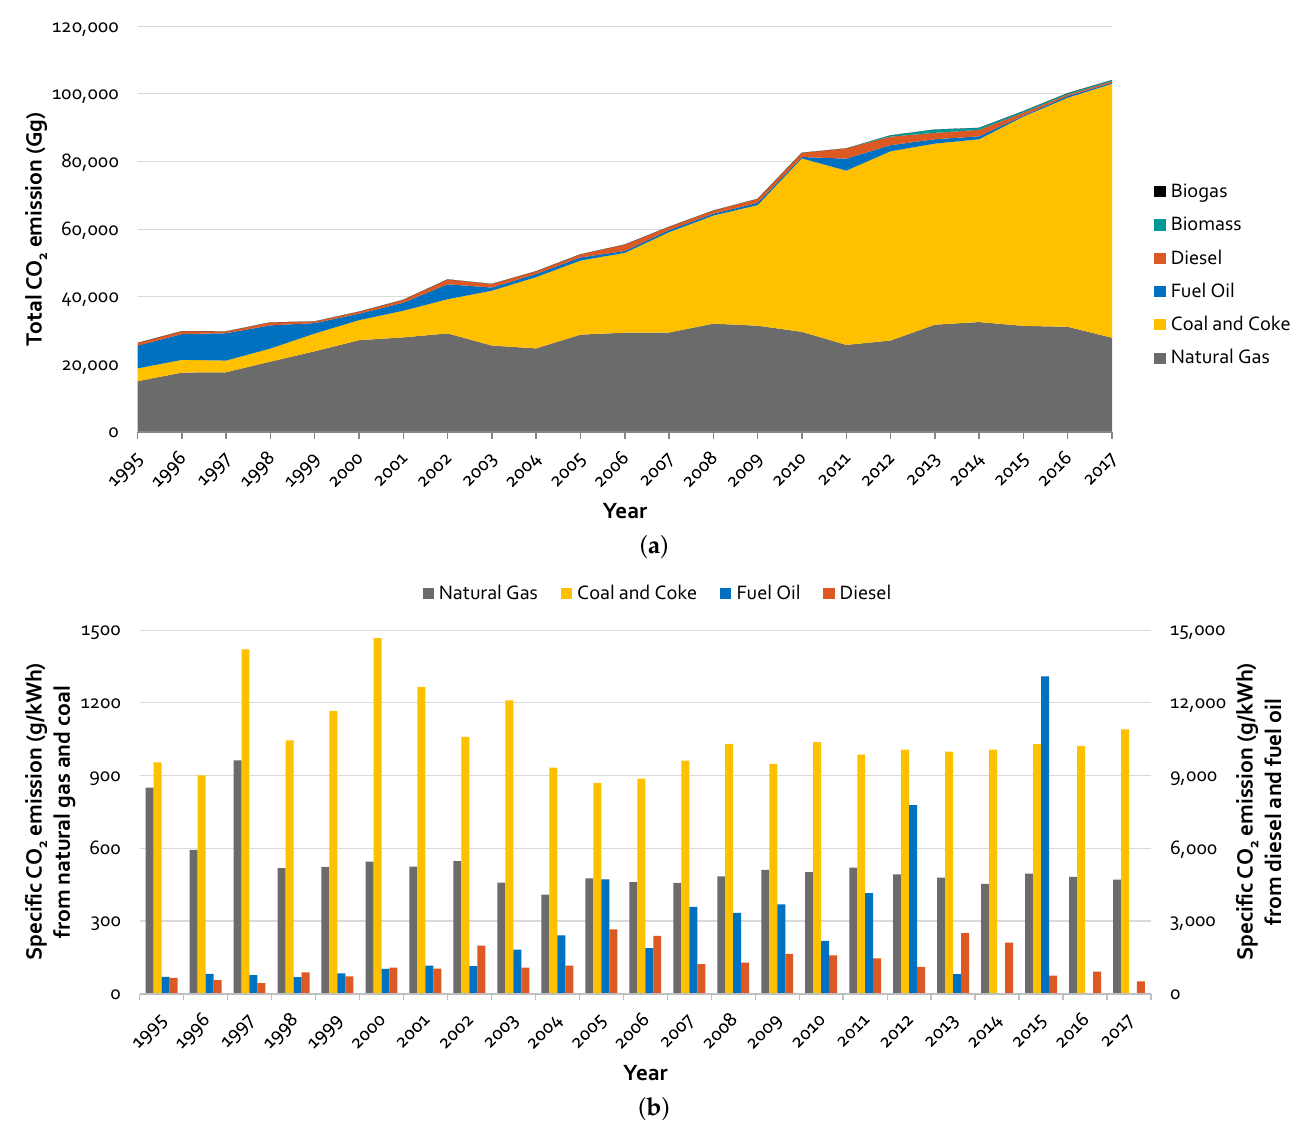
Figure 10. ( a ) Total annual and ( b ) specific CO 2 emissions from Malaysia electricity generation sector from 1995 to